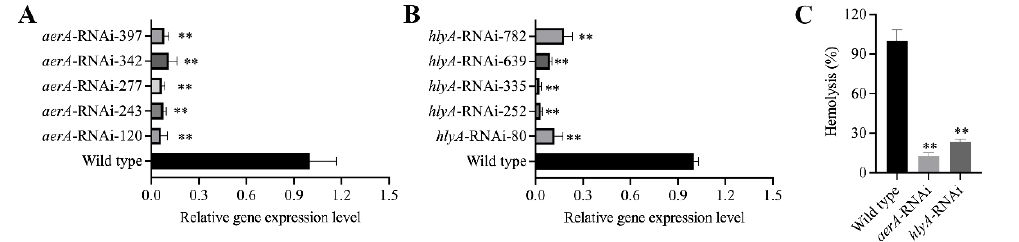
Figure 8. Effects of aerA and hlyA on the hemolytic activity and virulence of A . salmonicida . ( A , B ) To characterize effects of aerA and hlyA , five aerA ‐ and hlyA ‐ RNAi strains were constructed, and the silencing efficiencies were validated by qRT ‐ PCR; ( C ) shows the hemolysis (%) histogram of wild ‐ type, aerA ‐ RNAi, and hlyA ‐ RNAi A . salmonicida . Data are presented as mean ± standard deviation (SD) ( n = 3). ** p <